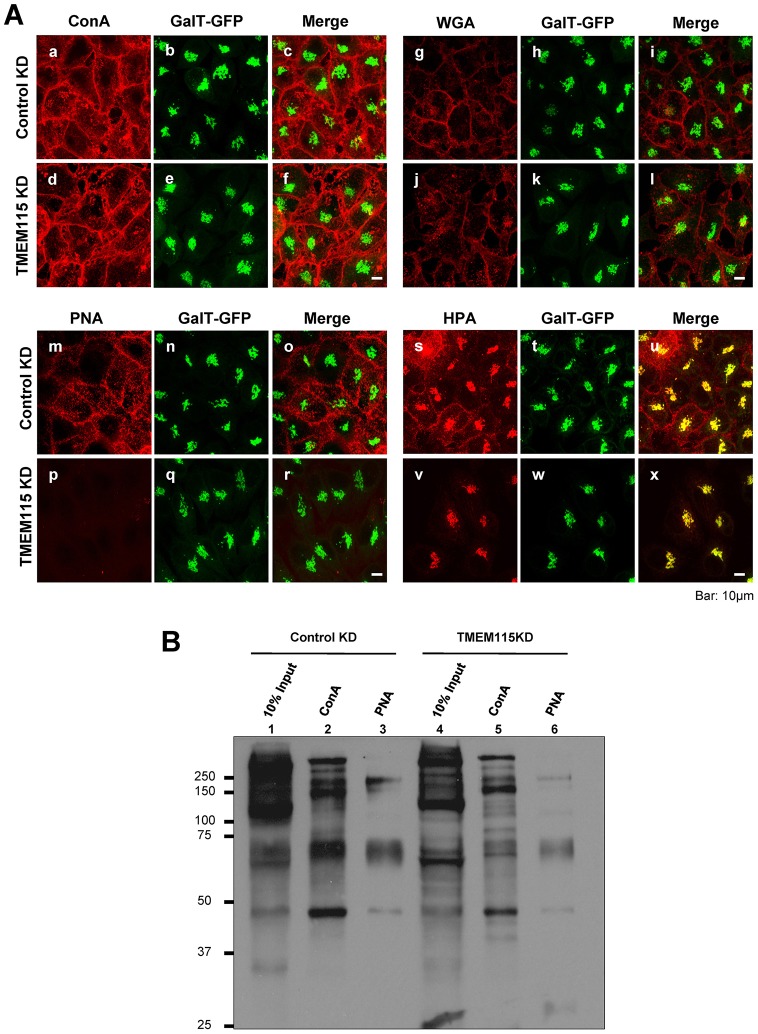
Gene silencing of TMEM115 affects glycosylation. (A) Glycosylation is affected in TMEM115 knocked-down cells. HeLa cells stably expressing GalT–GFP were transfected with either pooled siRNA targeting TMEM115 (right panels) or control pooled non-target siRNA (left panels). Non-permeabilized cells were labeled with fluorescent-dye-conjugated lectins. HPA mainly stains the Golgi complex (Campadelli et al., 1993; Virtanen, 1990) with very weak staining at the cell surface (de Albuquerque Garcia Redondo et al., 2004). Therefore, for proper visualization of HPA labeling, the cells were permeabilized with 0.1% Triton-X-100 prior to staining. Scale bar: 10 µm. (B) HeLa cells were transfected with either control non-target siRNA or TMEM115 siRNA. 72 hours after transfection, cells were surface-biotinylated and harvested. Cell lysates were incubated with streptavidin–agarose beads and biotinylated proteins were then eluted from streptavidin–agarose beads and incubated with either Concanavalin A (ConA)–agarose beads or PNA–agarose beads. Proteins were resolved by SDS-PAGE and visualized by western blotting using streptavidin–HRP.